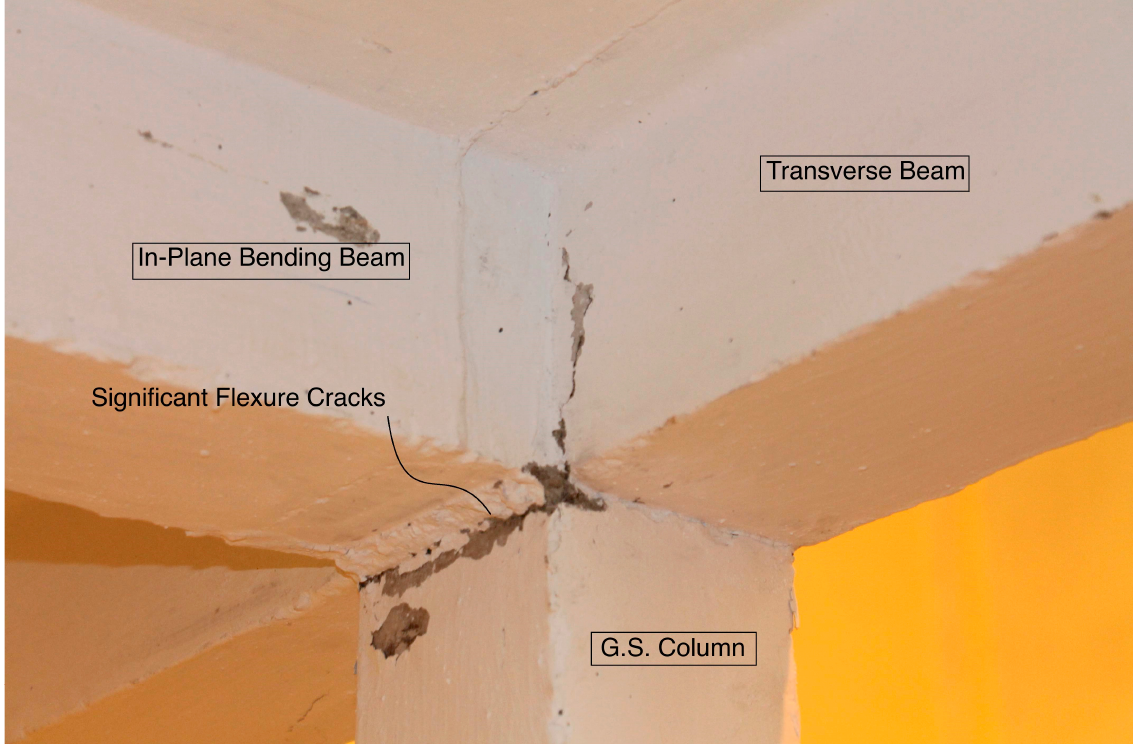
Figure 10. Aggravation of horizontal flexural cracks at the beam ends under test run 3 (ref. Table 3). G.S. column refers to the ground story column.